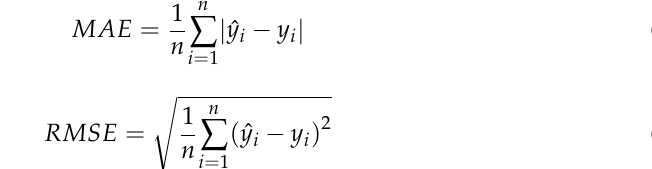
Figure 6. SSA-ELMAN fitness convergence curve.